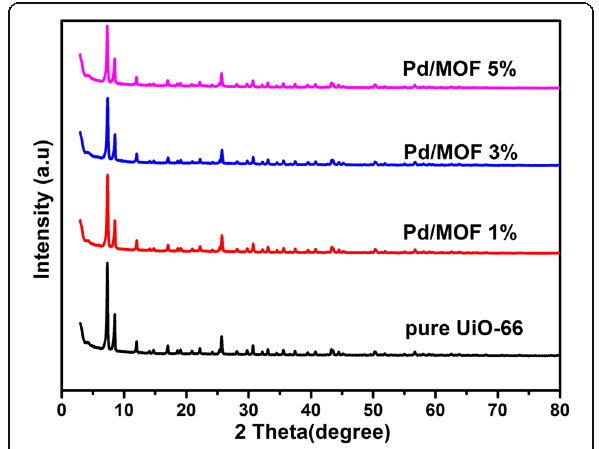
Fig. 3 The X-ray diffraction (XRD) patterns of pure UiO-66, Pd/MOF 1%, Pd/MOF 3%, and Pd/MOF 5%